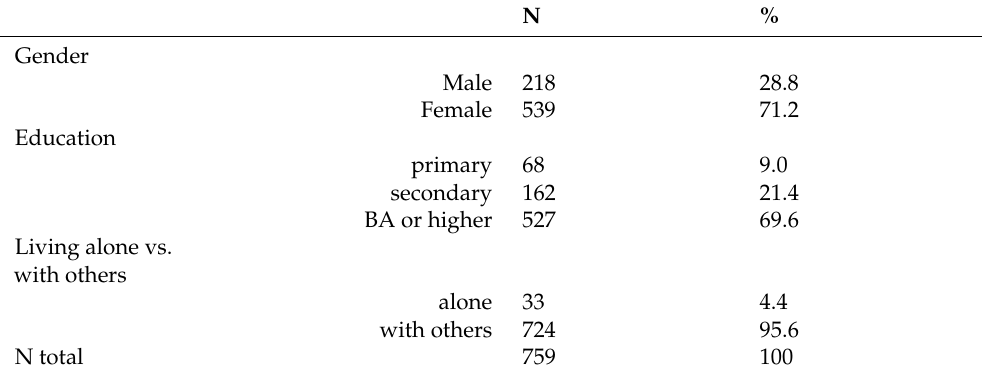
Table 1. Sociodemographic characteristic of the